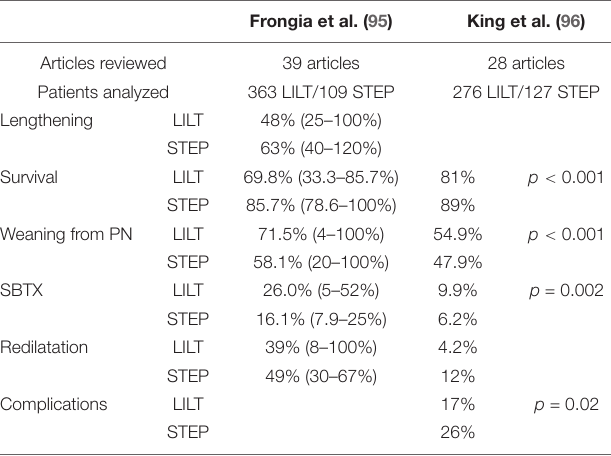
TABLE 2 | Summary of the results of systematic reviews on longitudinal intestinal lengthening and tailoring (LILT) and serial transverse enteroplasty (STEP). Frongia et al.